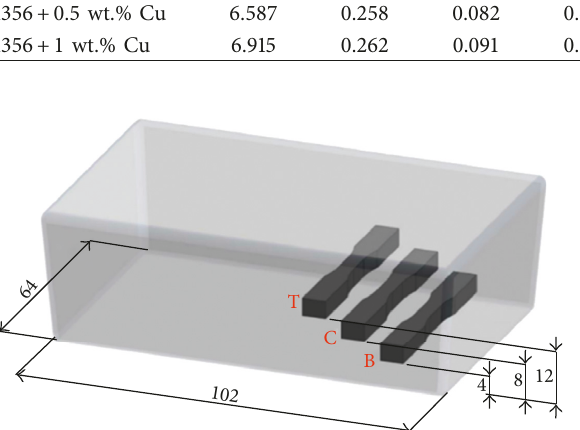
Figure 1: Specimen cutting position. B: bottom specimen, C: center specimen, and T: top specimen (values are given in mm).